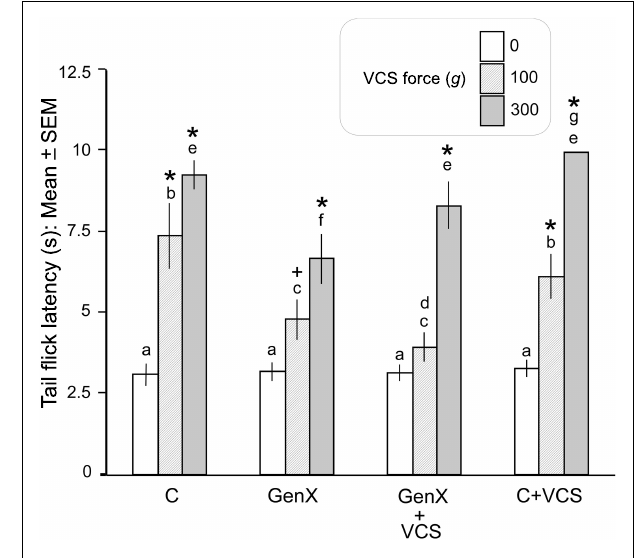
FIGURE 1 | Unilateral genital neurectomy significantly reduced the ability ofVCS to elevateTFL. Daily repeatedVCS in unilateral genital-neurectomized rats increased the ability of acuteVCS to elevateTFL compared to their controls that did not receive daily repeatedVCS (see text for details). C, intact controls; GenX, unilateral genital neurectomy; GenX + VCS, unilateral genital neurectomy plus daily repeatedVCS; C + VCS, intact rats receiving daily repeatedVCS. * p < 0.01, + p < 0.05; significantly greater, by Fisher’s protected t -test, than within-group baseline (0 g force of acuteVCS). Bars that do not share the same letters are significantly different from each other, within- or between-groups